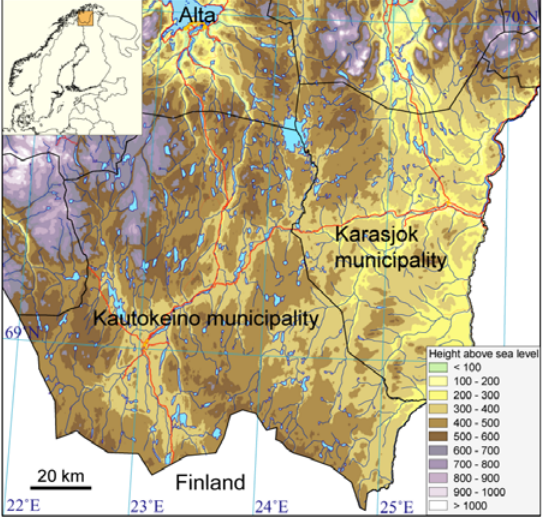
Fig. 1. A terrain model of the study area. The current tree line is formed by birch and is mostly between 420 and 480 meters